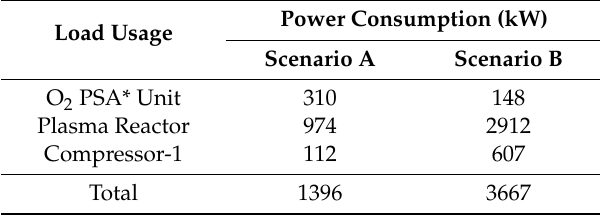
Table 1. Daily AC Electrical Load of a 10 Tons Per Day (TPD) Plasma-assisted HNO 3 Plant. Power Consumption (kW) Load Usage Scenario A Scenario B 310